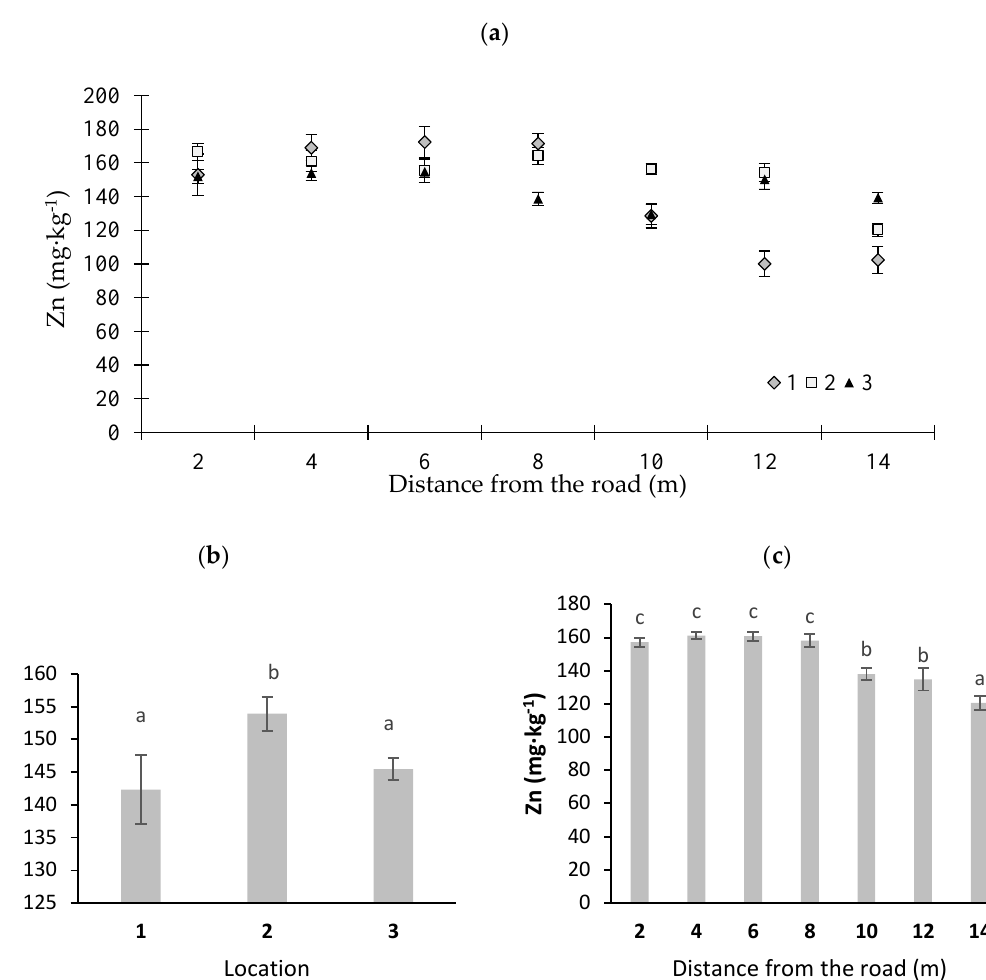
Figure 2. Zinc concentrations in moss ( Pleurozium schreberi ): ( a ) distance from the road at sampling location, ( b ) average Zn content at different locations, and ( c ) Zn content at different distances from the road (average values from three locations) ( n = 5, ±standard deviation). Different letters above bars representing lead concentrations for different locations or for different distances from the road indicate that they differed significantly (Tukey’s test, p < 0.01).